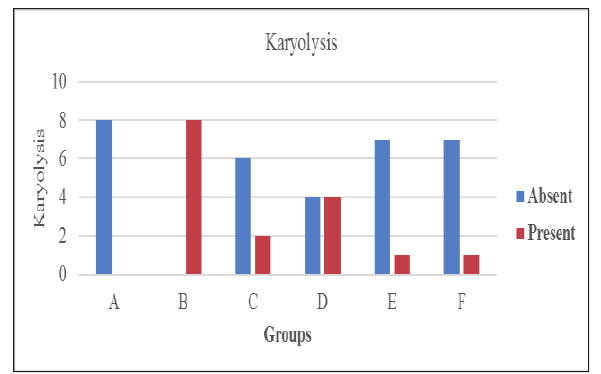
Fig-3: Comparison of karyolysis among groups A,B,C,D,E and F.